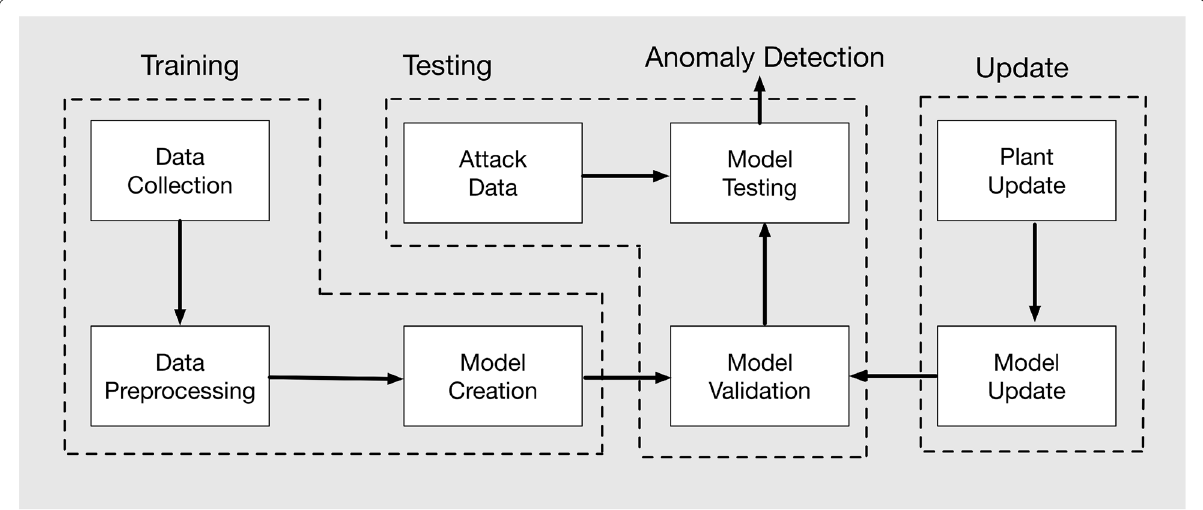
Fig. 3 Stages in the development of an anomaly detector using methods from machine learning: model creation (training phase), model deployment (testing phase), and retraining (update